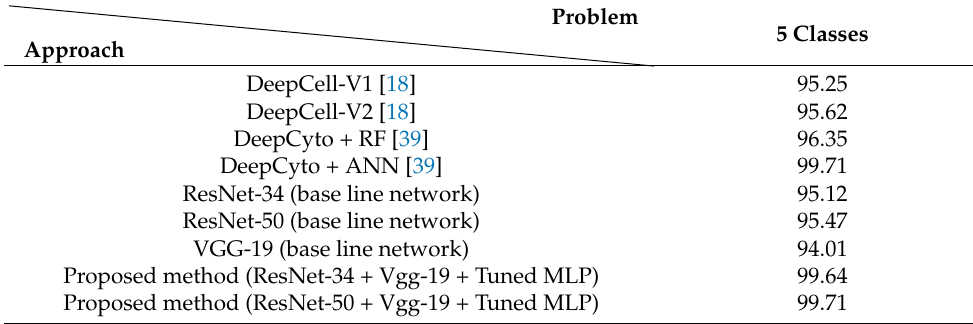
Table 7. Comparison results on the SIPKAMED dataset in terms of accuracy (%).